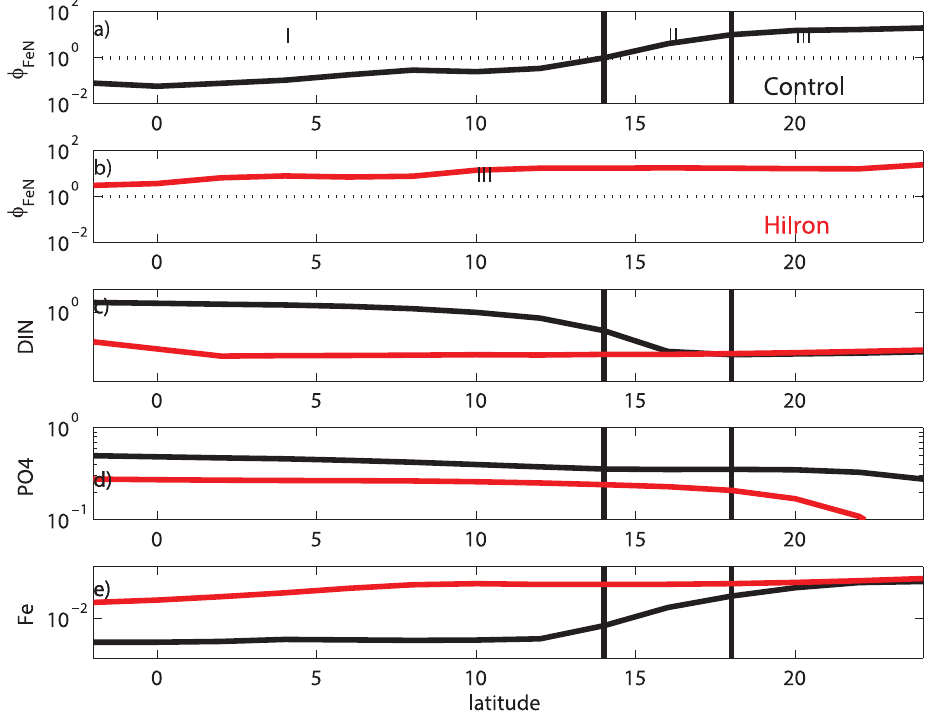
Figure 8. Model output from Pacific transect indicated in Fig. 3. (a) φ FeN for control simulation; (b) φ FeN for HiIron simulation with doubled dust; (c) DIN (mmolm − 3 ); (d) PO 4 (mmolm − 3 ); (e) iron (µmolm − 3 ). Vertical lines indicate province boundaries as determined only by presence or absence of diazotrophs, and limiting nutrient(s). Province labeled (I, II, III). Black lines indicate results from Control , and red lines from HiIron ; the whole transect is province III in Hilron (see Fig.